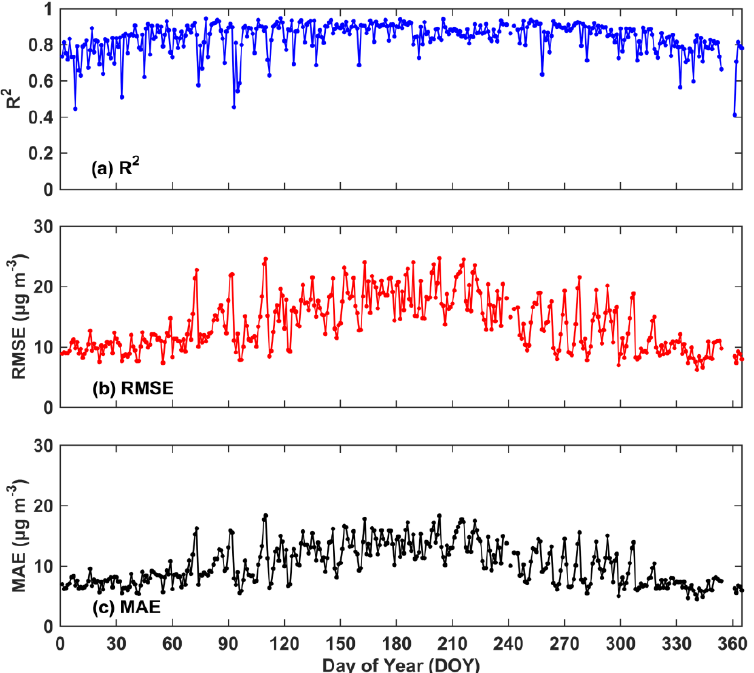
Figure 4. The temporal time series of the consistency between the two-stage model-derived concen- trations and surface measurements in 2018 across China. ( a – c ) was R 2 , RMSE and MAE, respectively.